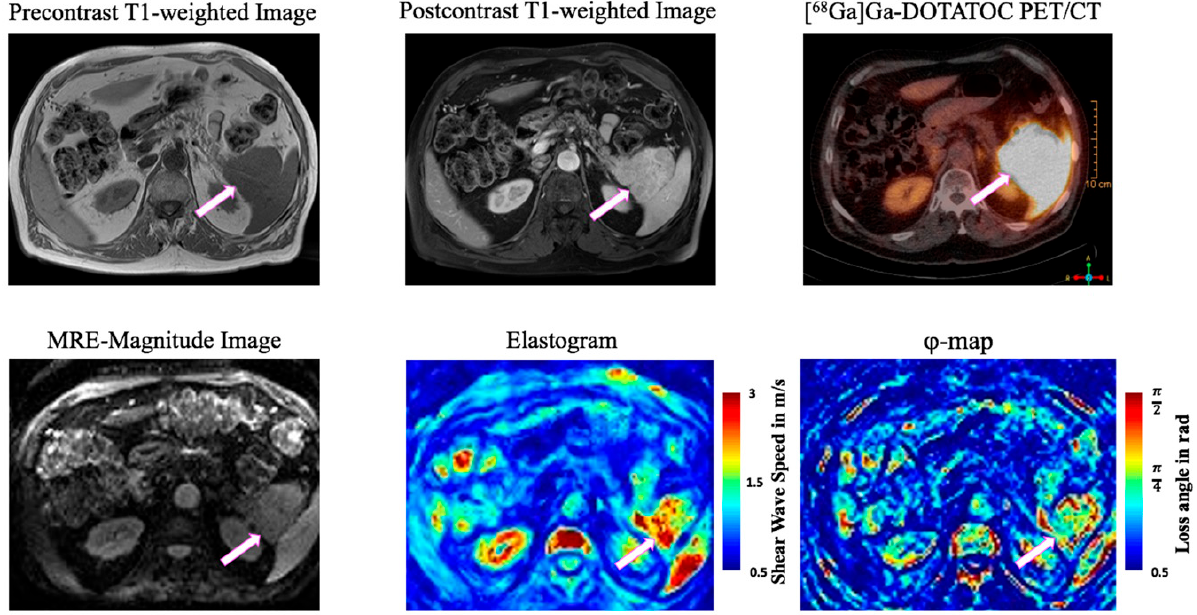
Figure 1. 79-year-old man with pancreatic neuroendocrine tumor (PNET, white block arrow) of the pancreatic tail. Unenhanced T1-weighted image with fat saturation, postcontrast T1w image, [ 68 Ga]Ga-DOTATOC positron emission tomography (PET)-CT, MRE magnitude image, elastogram and ϕ -map in axial plane. The tumor is characterized by low T1 signal intensity, marked contrast enhancement, PET avidity, increased stiffness (SWS) and increased loss angle of complex shear modulus ( ϕ ). Color bars represent shear wave speed (SWS) in m/s (red = high SWS, blue = low SWS) and loss angle ( ϕ ) in rad (red = high ϕ , blue = low ϕ ).